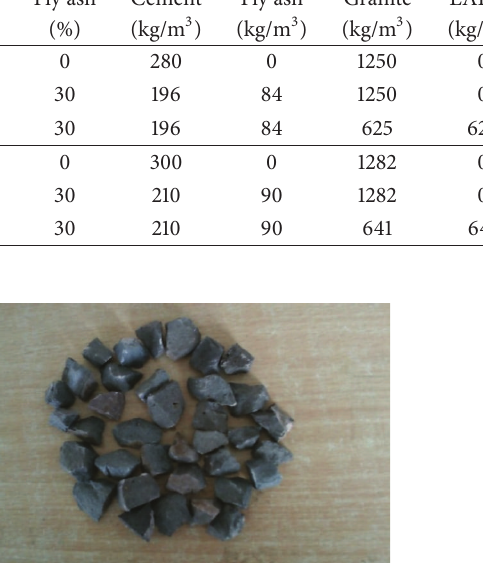
Figure 2: Crushed 20 mm EAF oxidizing slag